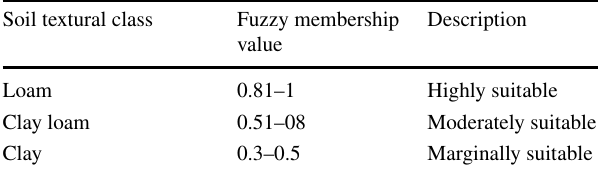
Table 6 Criteria for classification of soil depth in the study